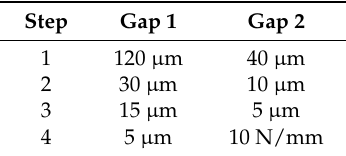
Table 3. Dispersion parameters on the three-roll mill.